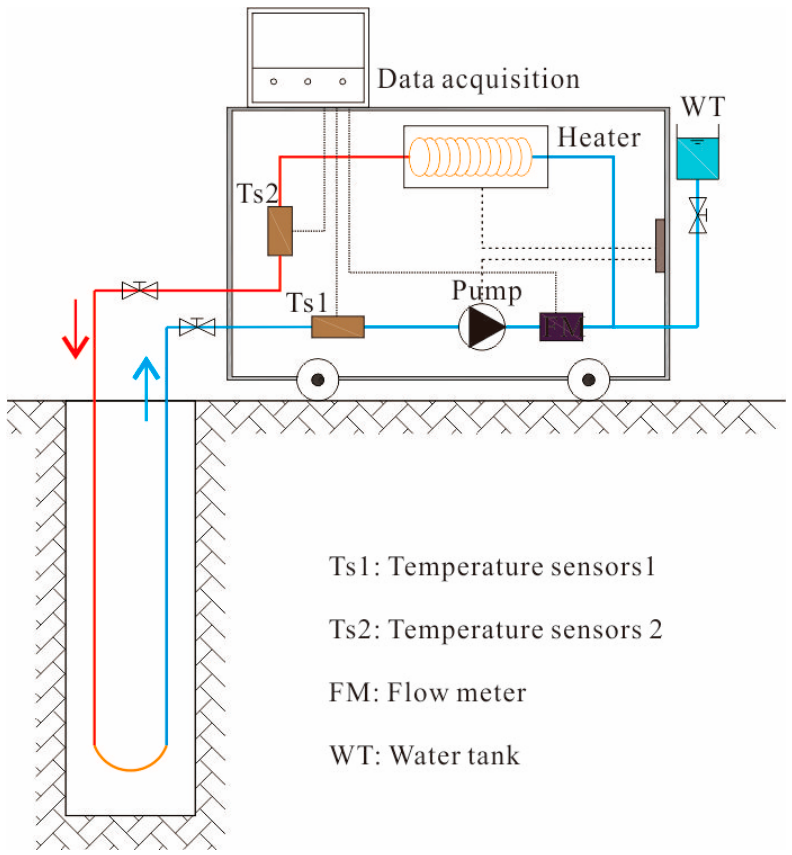
Figure 1. A schematic diagram demonstrates the testing device of a thermal response test.